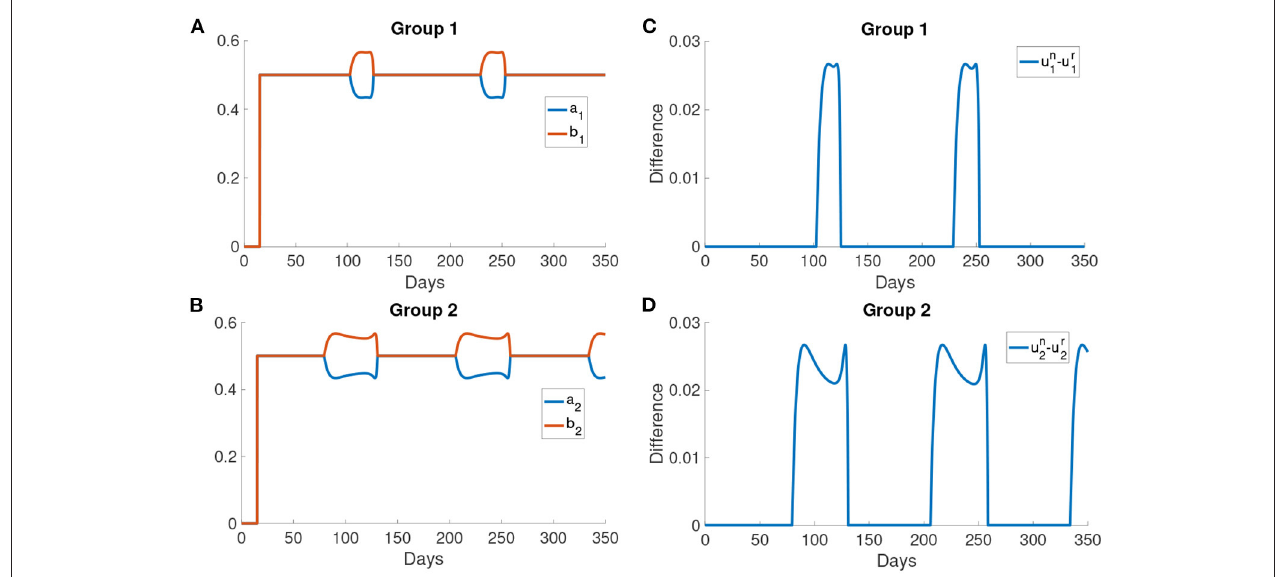
FIGURE 9 | The difference in the utilities and the rates of change a i and b i . (A,B) The difference in the utility of the normal activity type and the reduced activity type in different groups. The utility of normal activity type u n and the reduced activity type u r are calculated using Problem (6) and Problem (7). (C,D) The rates of changing type for different groups. a i is the rate at which normal activity type becomes reduced activity type. b i is the rate at which reduced activity type becomes normal activity